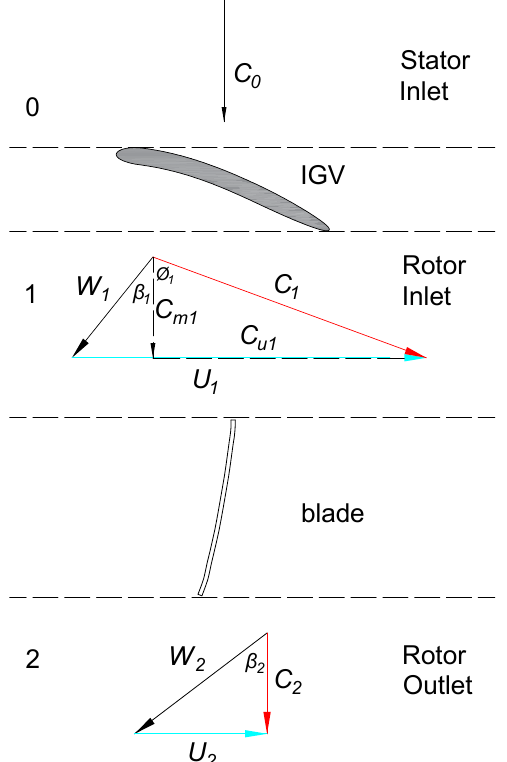
Figure 6. Velocity triangles for an RIF turbine with radial inlet flow and axial outlet flow adapted from [29]. C 0 is the radial flow into the turbine located at the base of the chimney. The numbers on the left indicate the turbine